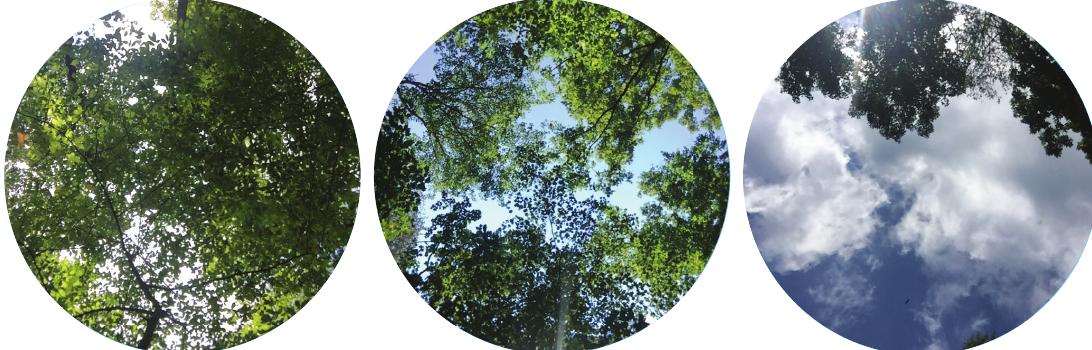
Figure 3. Hemispherical photographs taken from the center of unthinned ( left ), moderately thinned ( center ), and heavily thinned ( right ) main plots utilized in our study site in the Bridgestone–Firestone Centennial Wilderness, TN, USA during the peak flowering season of Platanthera integrilabia